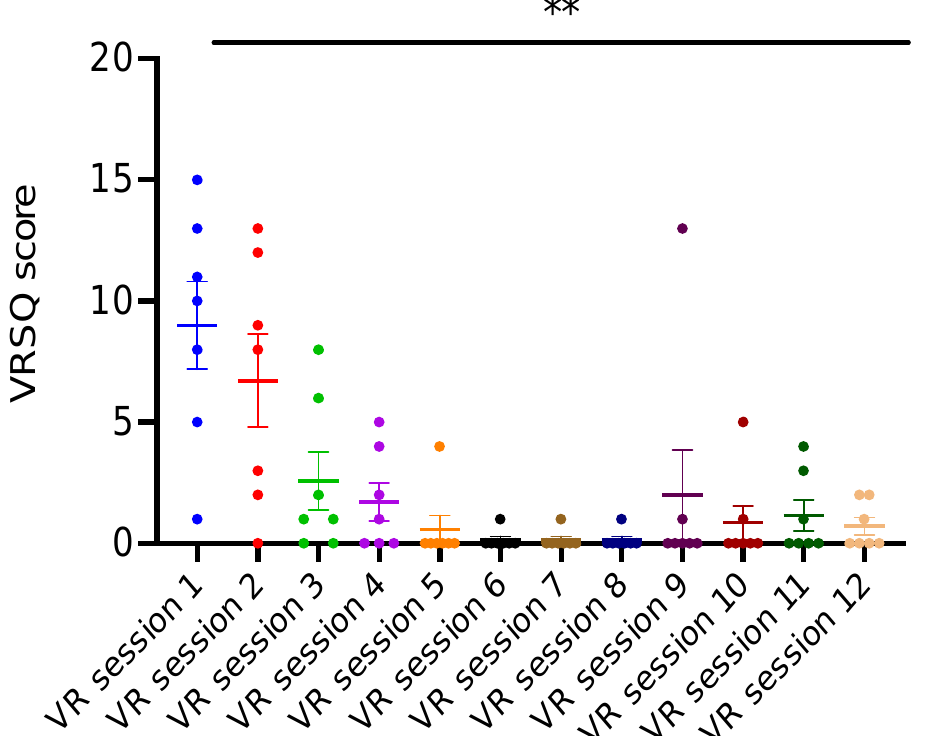
Figure 2. Participants’ tolerability to VR-based environmental enrichment as assessed by serial VRSQ scores. VRSQ scores of the participants across the 12 VR sessions significantly decreased in comparison to the first session (One-way repeated measures ANOVA; F = 9.18; ** indicate p < 0.01; n = 7; post hoc comparisons: VR session 1 vs. VR sessions 3,4,5,6,7,8,10,11,12 p < 0.05; VR session 1 vs. VR sessions 2, 9 p > 0.05). Error bars indicate standard error means.